Question: Produce a descriptive caption suitable for publication.
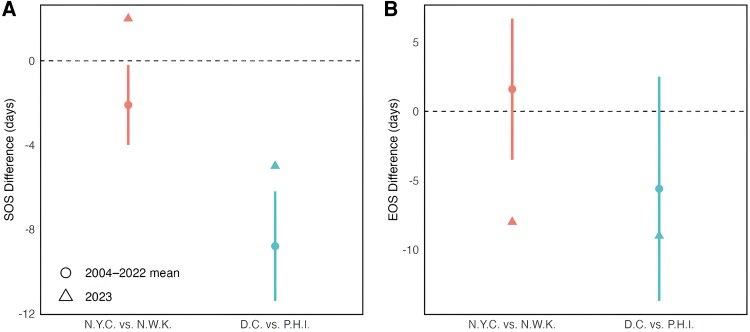
Answer: Comparison of differences in SOS (a) and EOS (b) between paired cities with and without ALAN-mitigation policies, based on long-term means (2004–2022) and postpolicy periods (2023 only). Values are calculated by subtracting phenology at ALAN policy cities from nonpolicy cities for each pair (e.g. NYC vs. Newark; DC vs. Philadelphia). Positive values indicate later phenological timing in policy cities relative to nonpolicy cities. Error bars represent 1 SD across the prepolicy years.